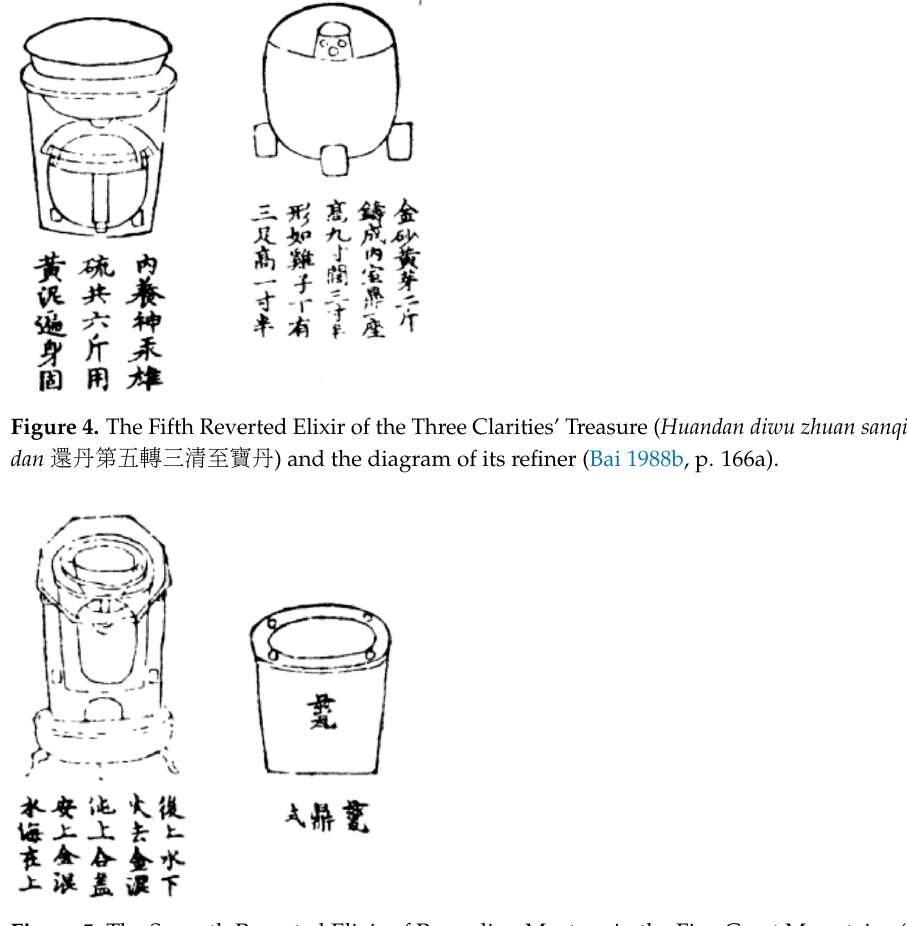
Figure 5. The Seventh Reverted Elixir of Pervading Mystery in the Five Great Mountains ( Huandan diqi zhuan wuyue tongxuan dan 還丹第七轉五嶽通玄丹 ) and the diagram of its refiner (Bai 1988b, p. 167a).